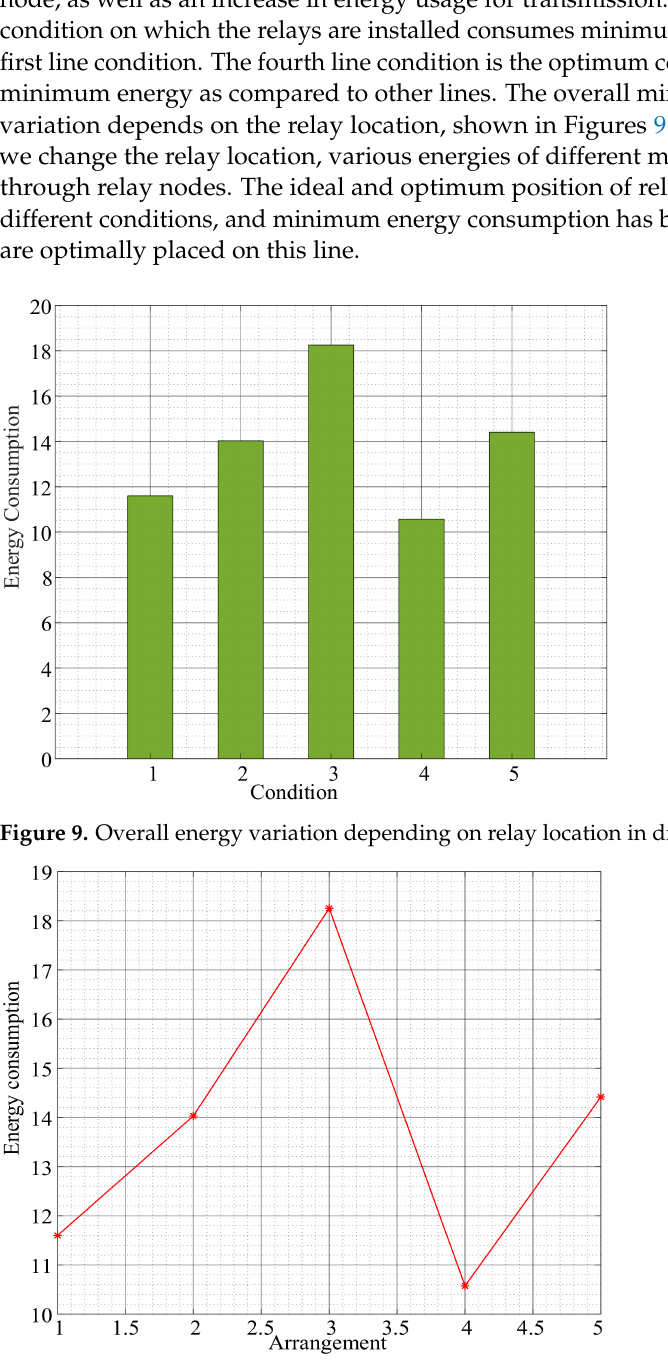
Figure 10. Overall energy variation depending on relay location in different